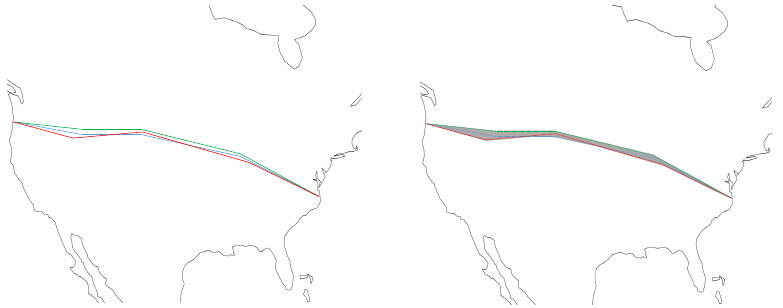
Figure 7. 2D CoO generation from three ensemble trajectories ( left ) to a concave shape encasing all waypoints ( right